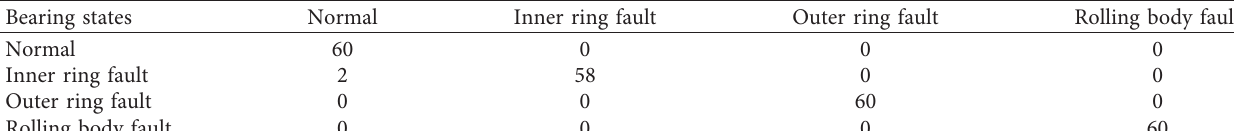
Table 5: Confusion matrix of test results with